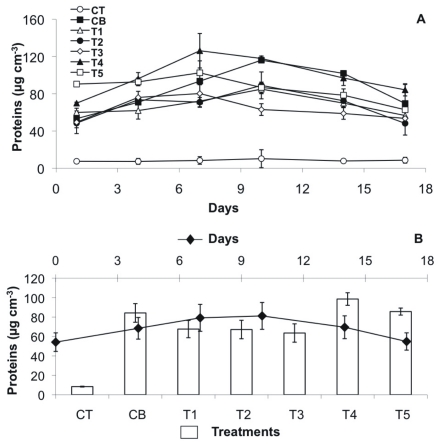
EPS protein concentrations over the course of the experiment.(A) Mean values (n = 4 per treatment, based on n = 3 replicates per box) with SE of the different treatments over time: positive control CB (black squares), negative control CT (white circles), T1 (TCS: 2 µg/L, white triangles), T2 (TCS: 10 µg/L, black circles), T3 (TCS: 20 µg/L, white diamonds), T4 (TCS: 50 µg/L, black triangle), T5 (TCS: 100 µg/L, white squares). (B) Mean values with SE per day (n = 7, black diamonds) and per treatment (n = 6, bar plots).